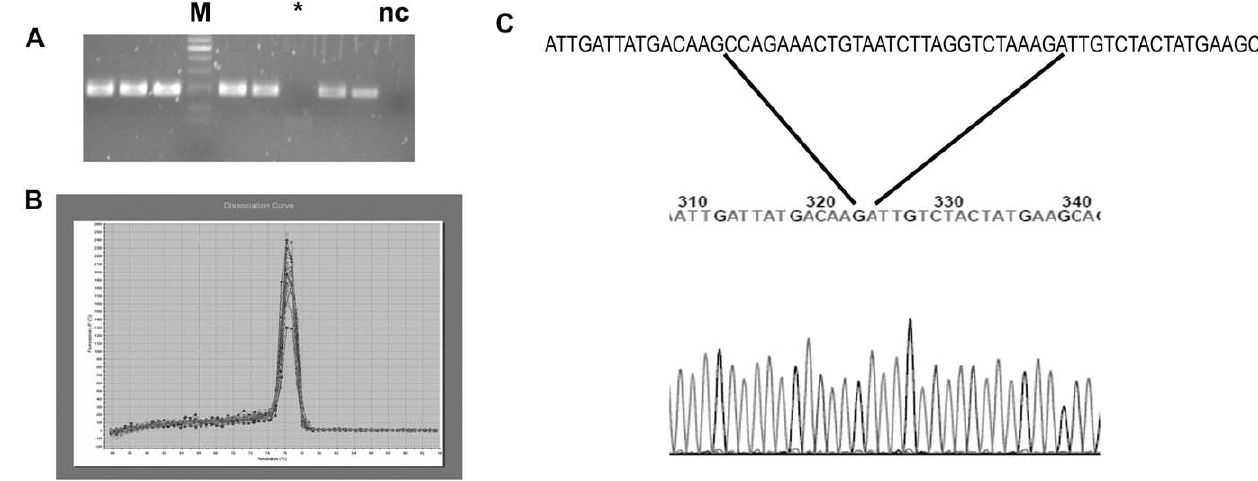
Figure 2. Splice variants of CD133. Cell lines and normal mucosal samples were tested for expression of the two main CD133 splice variants by RT- PCR with primers anchored on either side of the spliced out exon (exon 4). Sample data are shown which demonstrate only a single product was identified when PCR products were analysed on both (a) agarose gel and (b) the more sensitive Q-PCR technique using Sybr green as a reporter. M = size marker, nc = negative control, * represents DLD1. (c) Sequencing of the products showed that exon 4 was spliced out of the coding sequence thus only shorter splice variant (AC133-2) was being expressed. The sequence above the electropherogram is of AC133-1 with exon 4 shown between the lines.